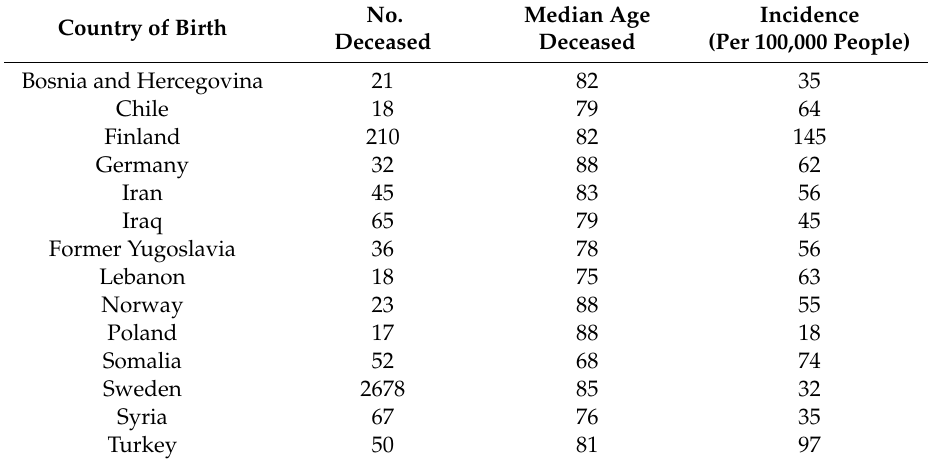
Table 2. Report by Swedish Public Health Agency (Folkhälsomyndigheten) on the number of deceased by country of birth, median age and incidence (number of deaths per 100,000 people), during the period of 13 March–7 May 2020. Countries with fewer than 11 deaths are not reported [7]. No. Median Age Incidence Country of Birth Deceased Deceased (Per 100,000 People) Bosnia and Hercegovina 21 82 35